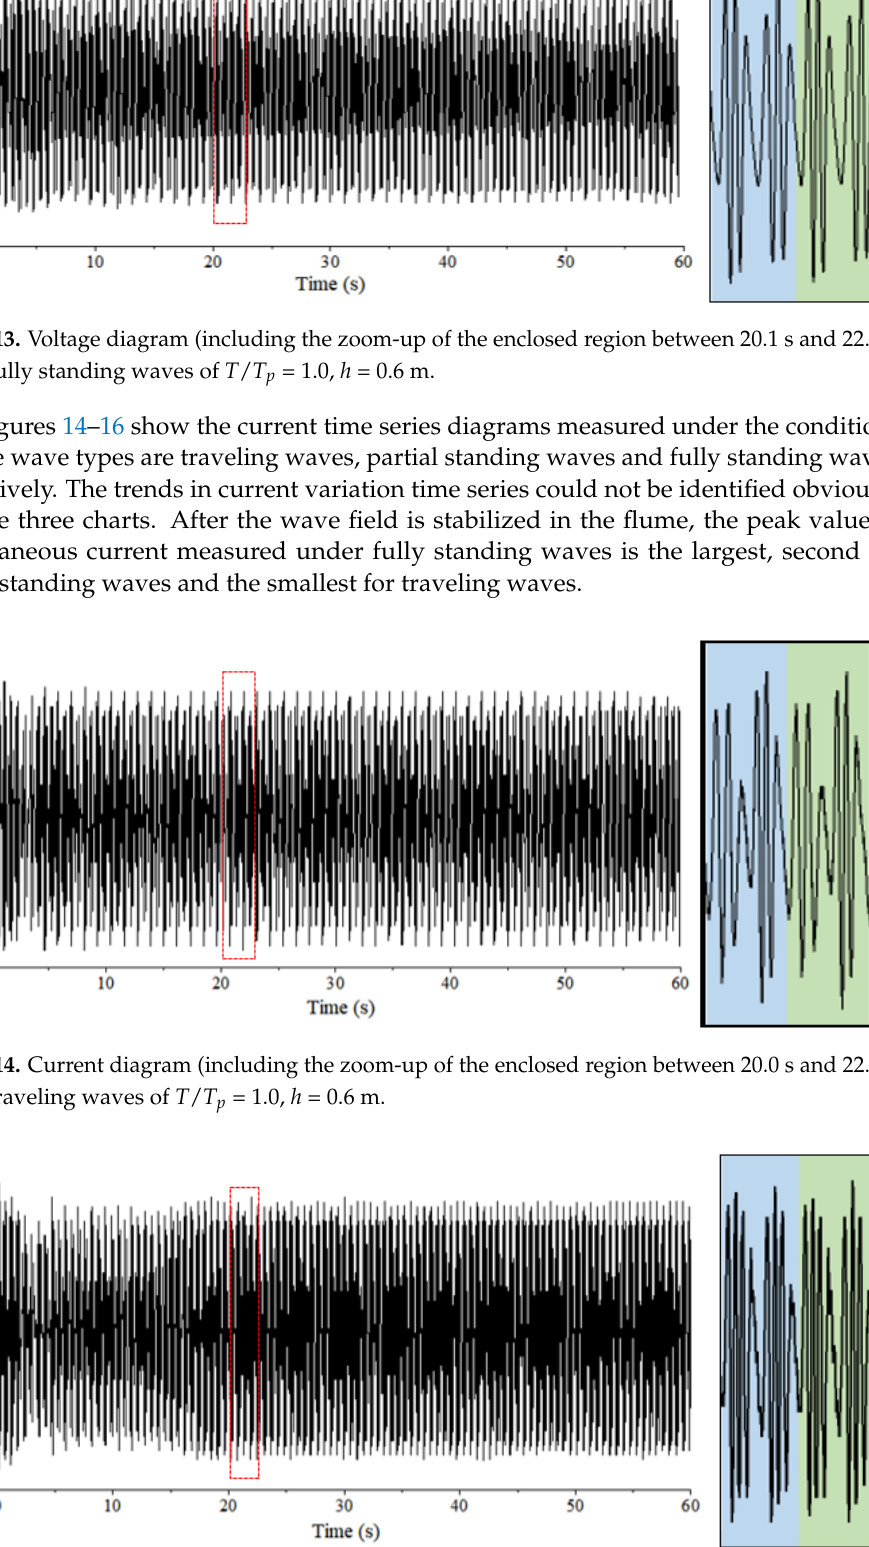
Figure 12. Voltage diagram (including the zoom-up of the enclosed region between 20.0 s and 22.3 s) under partial standing waves of T / T p = 1.0, h = 0.6 m (Reproduced from ref.35 with permission from Springer Nature).